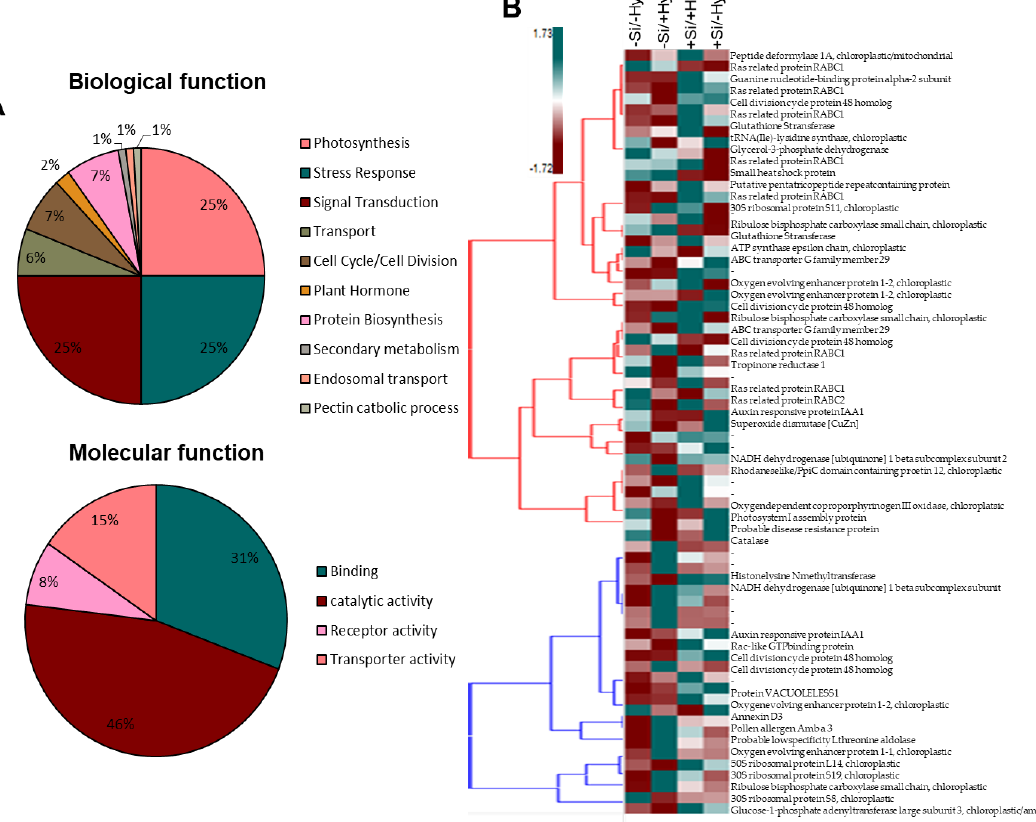
Figure 4. ( A ) functional classification of identified proteins and ( B ) heatmap of the differentially expressed protein spots under hyperhydricity and silicon (Si) treatments (−Si/−Hyperhydricity; −Si/+Hyperhydricity; +Si/+Hyperhydricity; +Si/−Hyperhydricity) in shoot cultures of carnation ( Dianthus caryophyllus L.) grown in vitro .